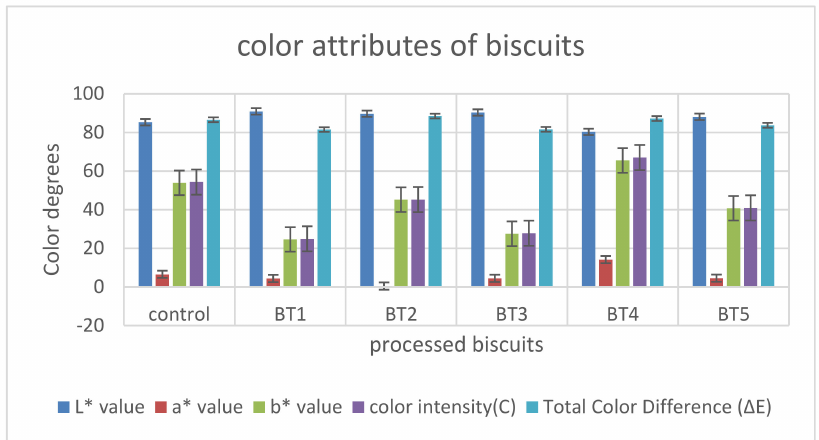
Figure 5. Color attributes of